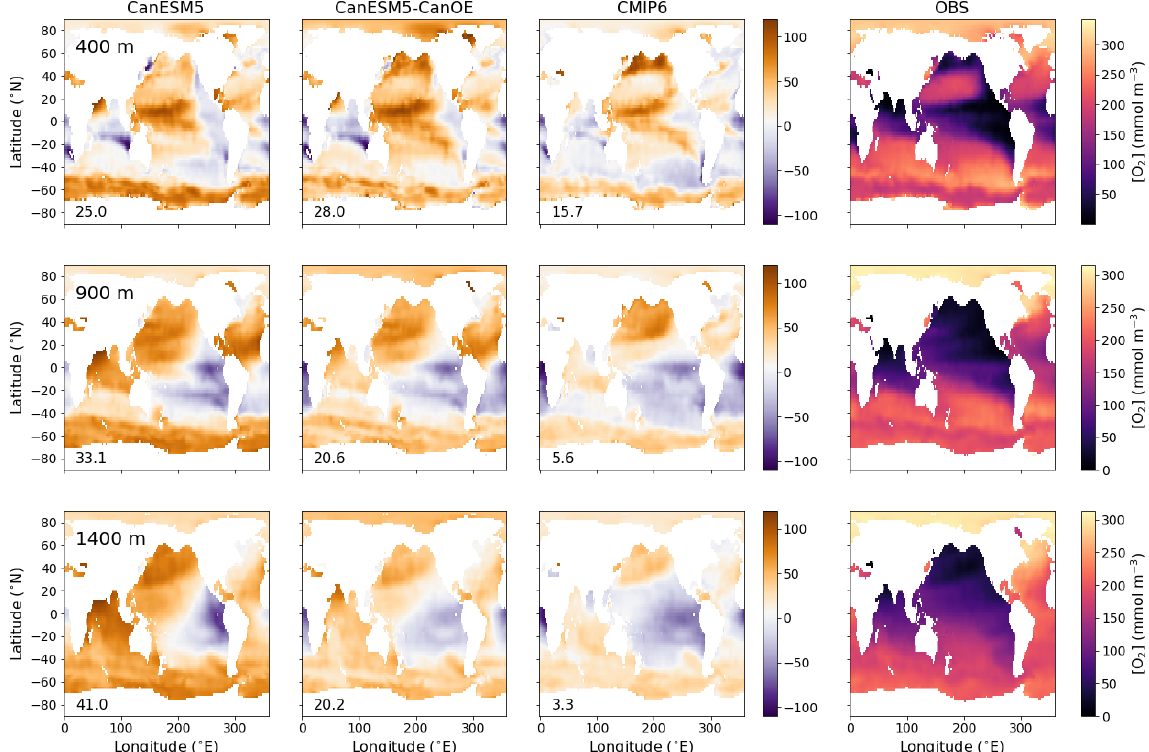
Figure 2. Global distribution of oxygen (O 2 ) concentration in mmolm − 3 at 400, 900, and 1400m (rows) for CanESM5-CanOE, CanESM5, the mean for other (non-CanESM) CMIP6 models, and World Ocean Atlas 2018 (WOA2018) observations (columns). Numbers on the lower left are the mean model bias. Differences from the observation-based fields are shown in Fig. S2 in the